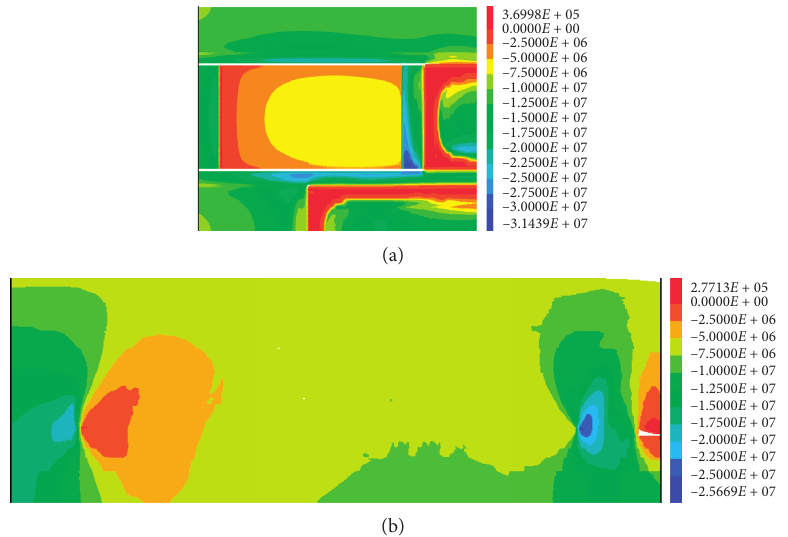
Figure 9: Nephogram of stress distribution of E1302 working face after filling and mining.